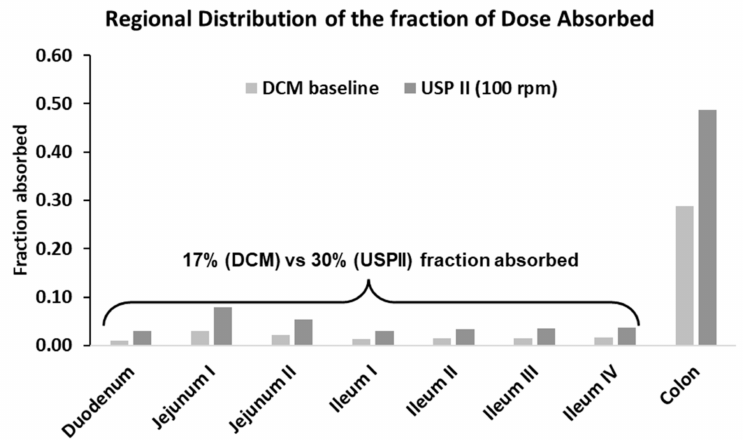
Figure 7. Simulated fraction absorbed from GI regions after incorporation of the in vitro dissolution profiles of the Uniphyllin Continus ® tablet (400 mg), derived from USP II and DCM, into the ADAM